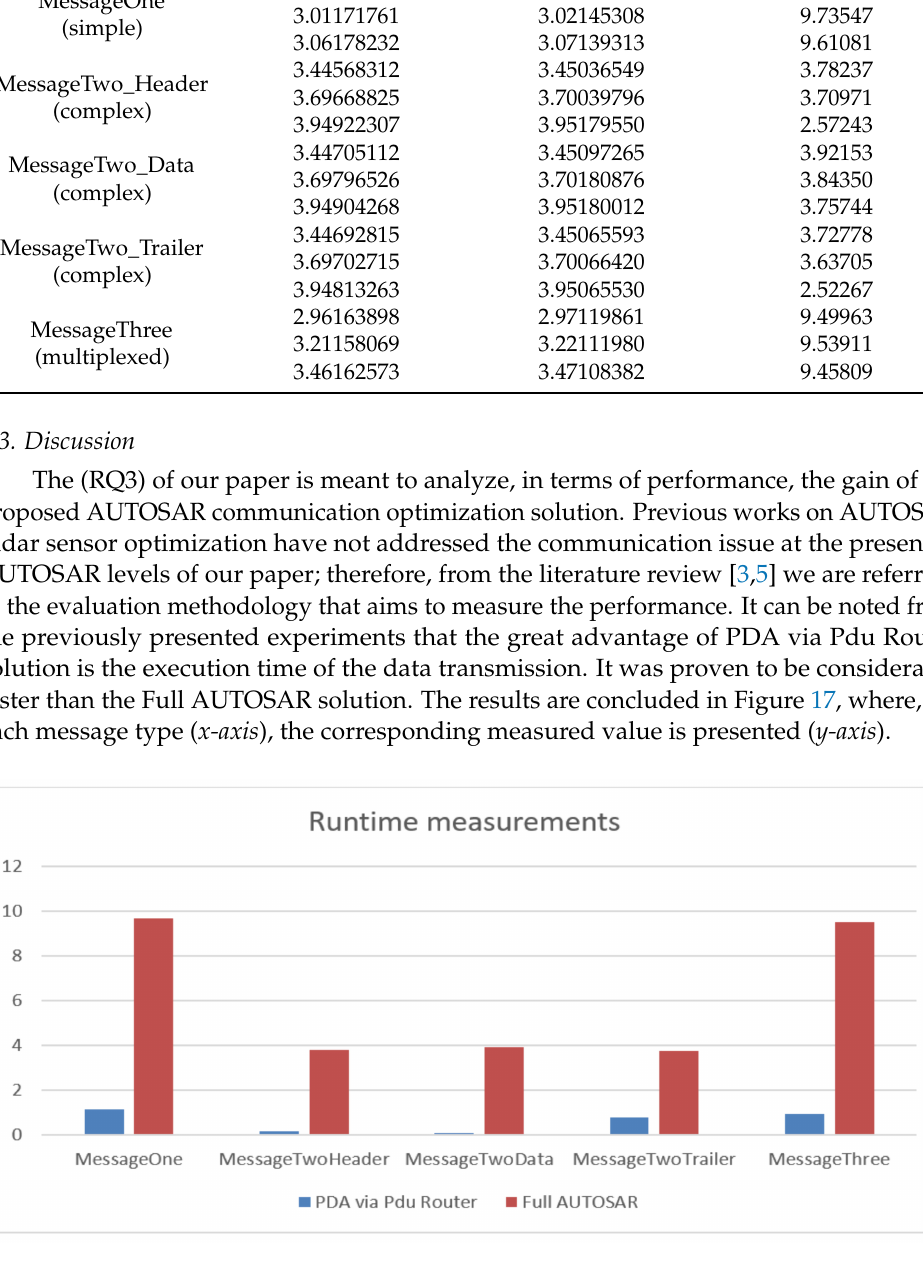
Figure 17. Runtime measurements